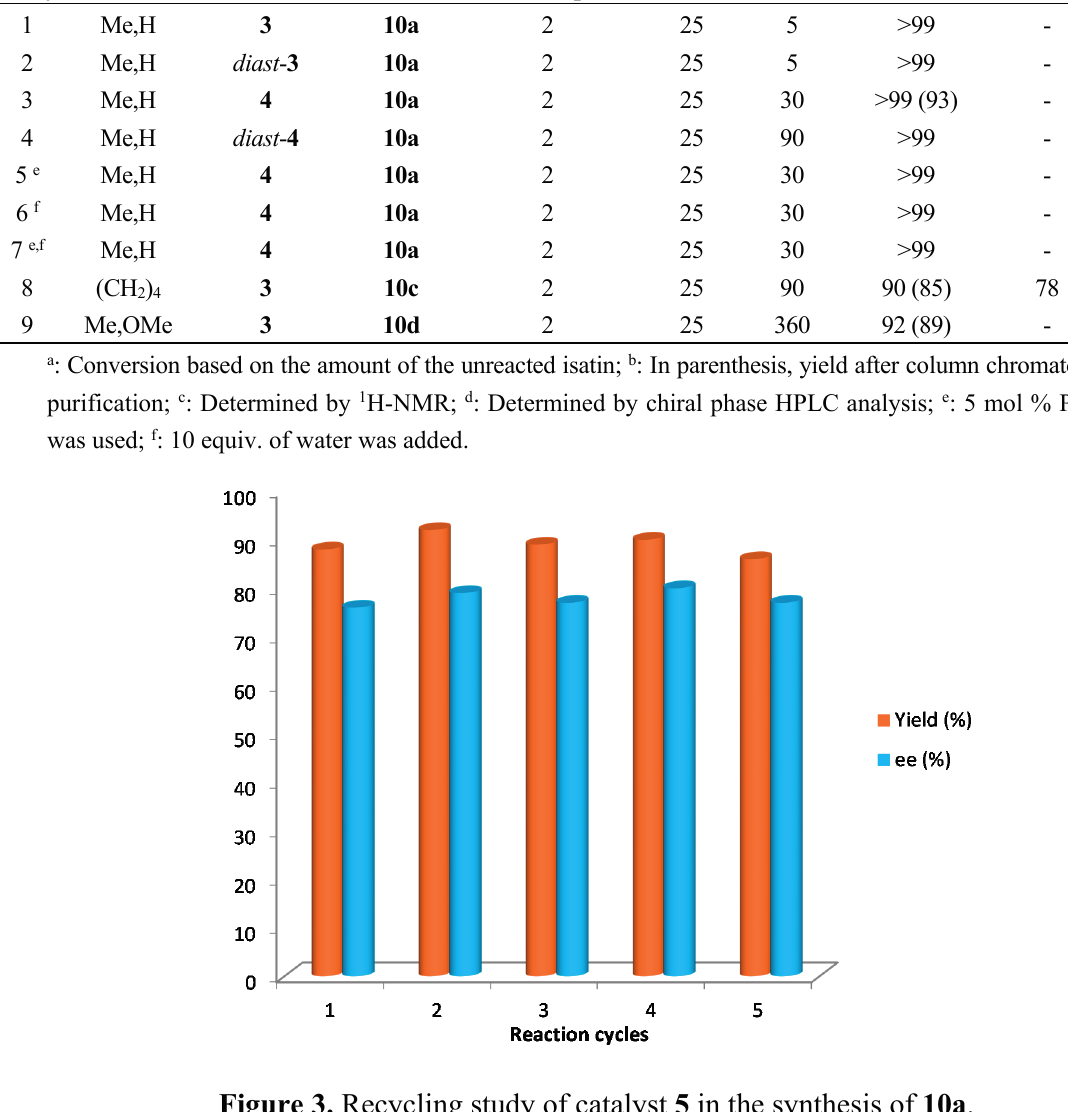
Figure 3. Recycling study of catalyst 5 in the synthesis of 10a